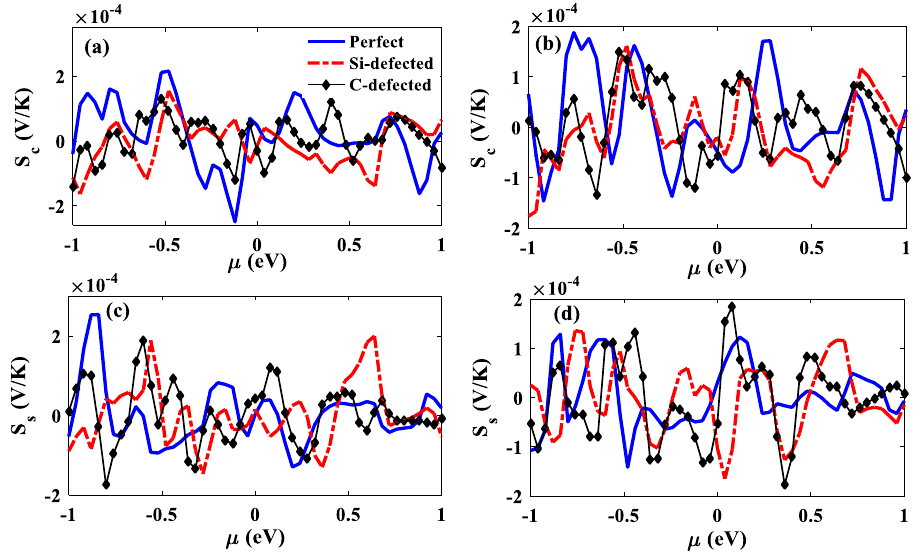
Figure 8. The charge Seebeck coefficient, S c , and the spin Seeebeck coefficient, S s , of the perfect (solid lines), Si-defected (dot-dashed lines), C-defected (dashed lines) junctions as a function of chemical potential for P ( a and c ) and AP ( b and d ) electrodes configurations .